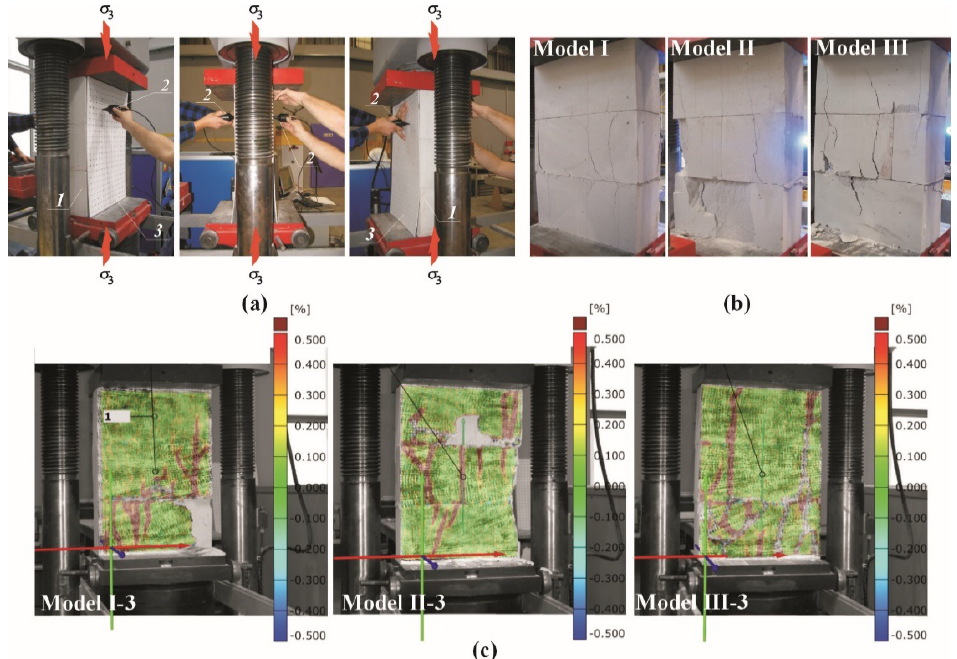
Figure 13. The procedure employed in Stage II to test the AAC wall models: ( a ) measurements of velocity of the ultrasonic wave at different stress value σ 3 , ( b ) selected models at failure, ( c ) vertical strains of selected wall models under stress σ 3max ; 1—masonry units, 2—ultrasonic transducers, 3—templates to arrange symmetrically ultrasonic